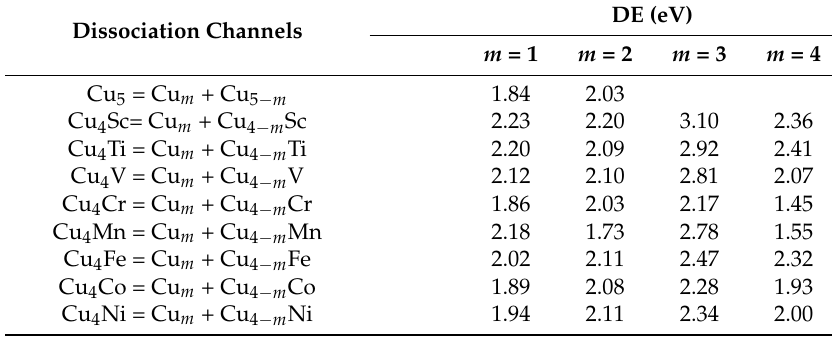
Table 4. The dissociation energy (DE) of Cu 5 and Cu 4 M (M = Sc-Ni) clusters for the distinct dissociation